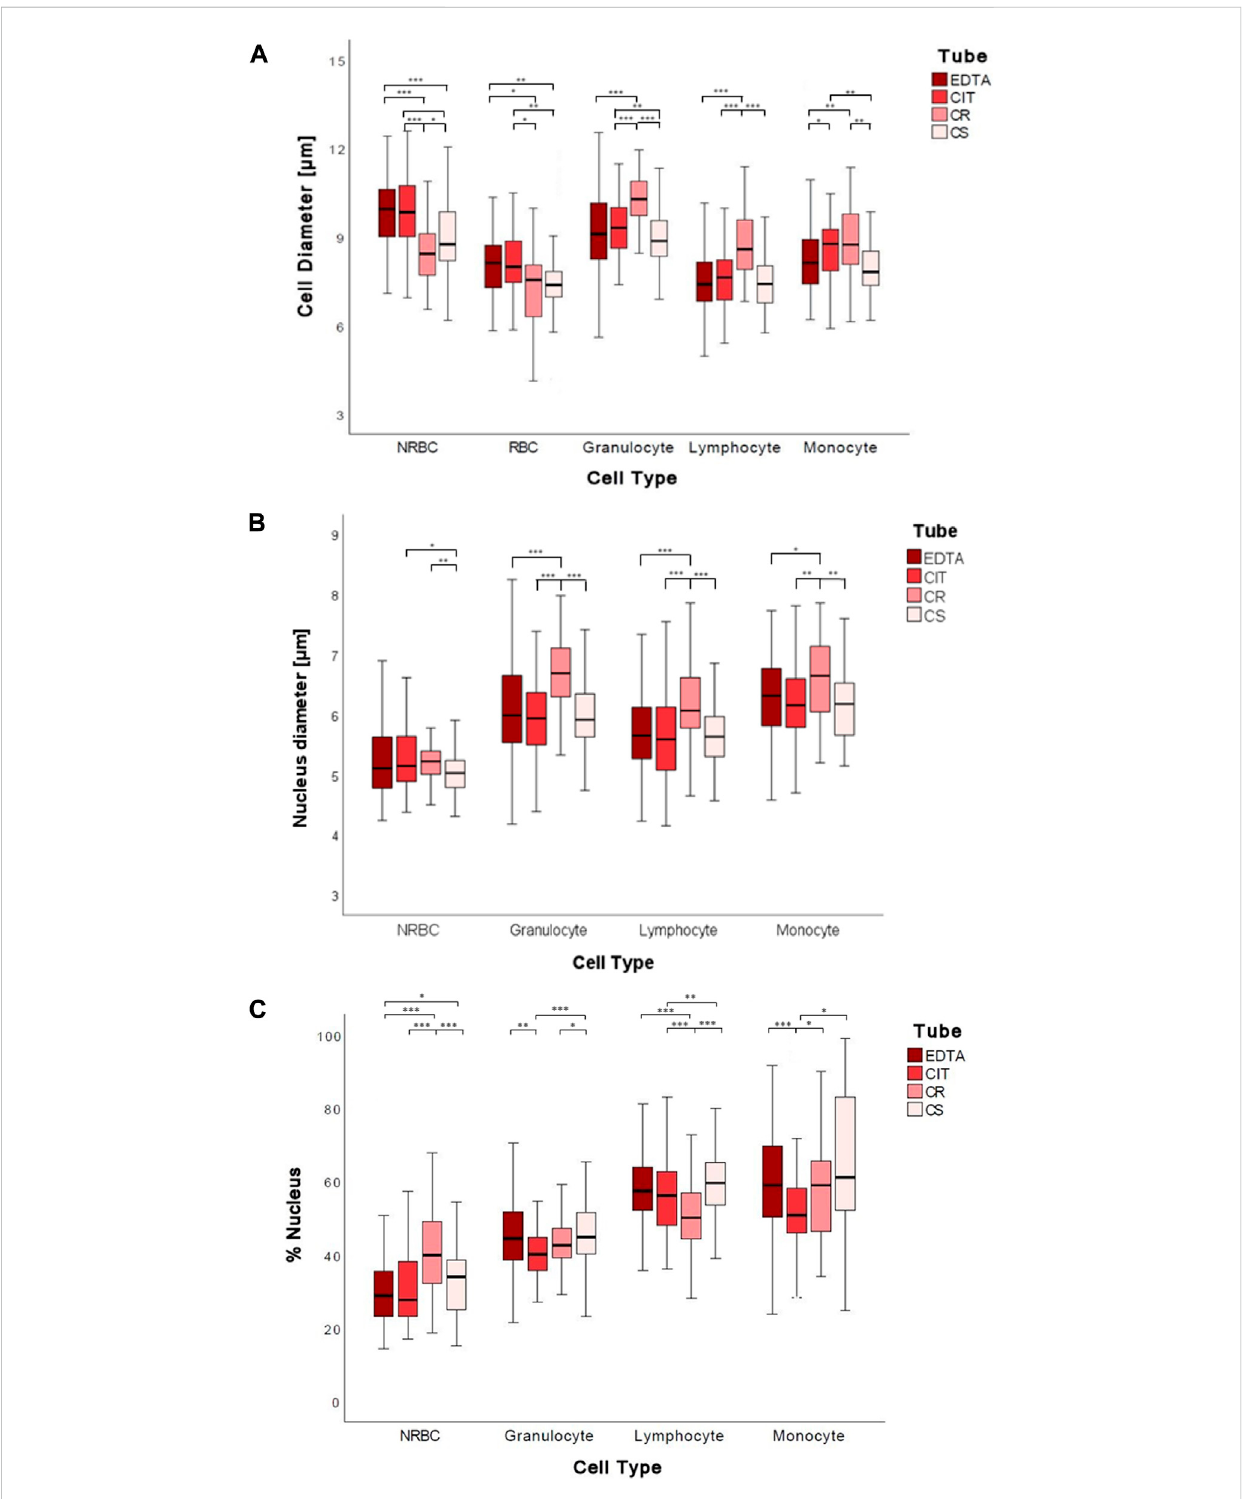
FIGURE 3 Boxplots of 2D cell diameters (A) , nuclear diameters (B) , and percentage of the nucleus (C) measured in µm for each tube for each cell group. The symbol * represents a statistically signi fi cant difference ( *p < 0.05; **p < 0.01; ***p <